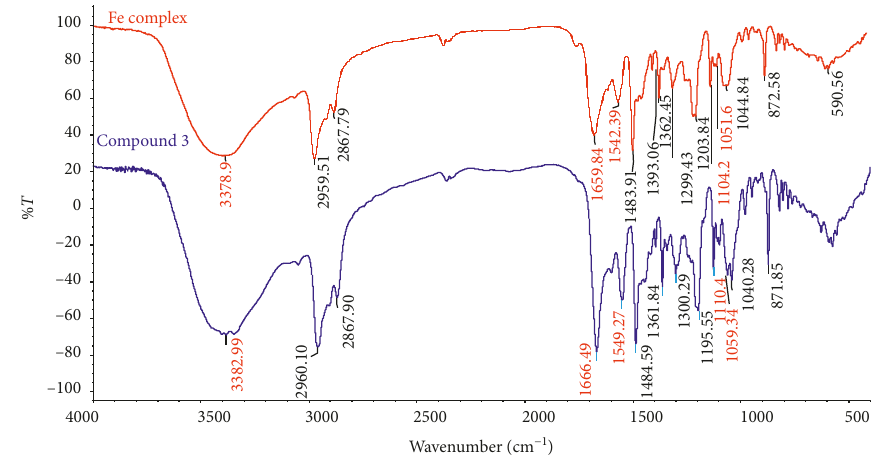
Figure 6: FT-IR spectra of compound 3 (L) and its complex with Fe 3+ . Table 2: Zones of inhibition for antimicrobial activities of the tested derivative (L).